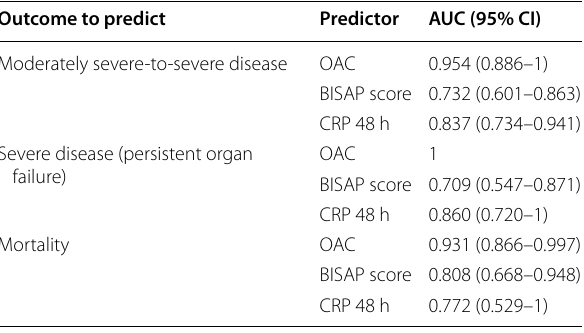
AUC Area under the receiver operating characteristics curve, CI confidence intervals, OAC oleic acid chlorohydrin, BISAP Bedside index of severity in